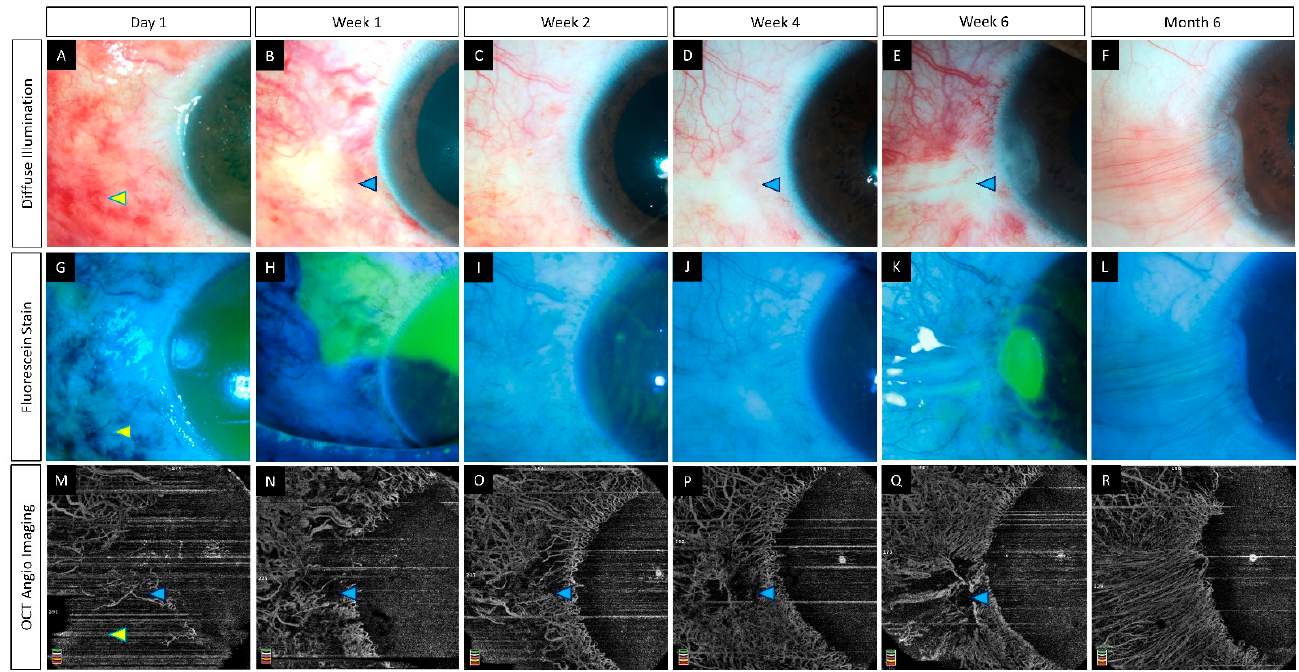
Figure 7. ( A – R ) Serial imaging with slit lamp photographs (without and with fluorescein staining) and optical coherence tomography angiography imaging in an eye with acute chemical burns. ( A – L ) These images depict a total corneal epithelial defect with an adjacent conjunctival defect at presentation, which decreased in size and ultimately healed after 2 weeks. ( M – R ) The corresponding angiography images illustrate an initial masked signal due to the sub-conjunctival hemorrhages (yellow arrowheads) which recovered with the resolution of the hemorrhages. Persistent ischemia is noted in the limbal area abutting the cornea (blue arrowheads) with epithelial healing issues in the adjacent cornea at the 6th week visit. A partial LSCD is noted in the same area at the 6th month follow-up ( F ) .